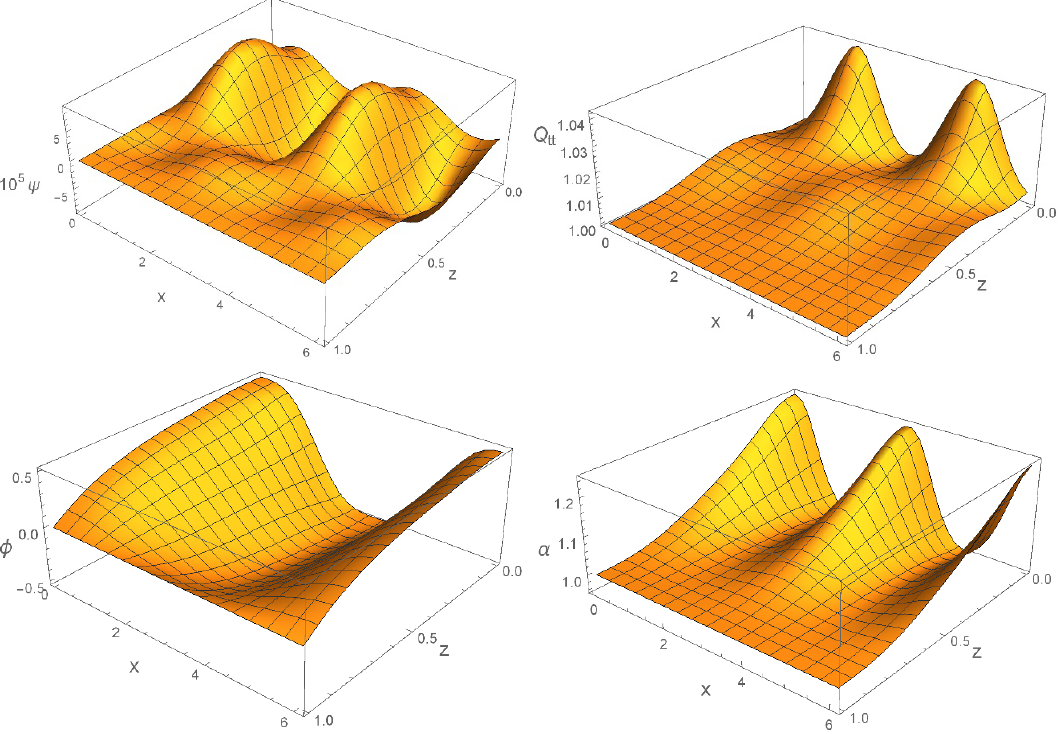
Figure 15 . Bulk solutions for T = 0 : 00737 (cid:22) and k = 1 in the presence of axions. The horizon is at z = 0 and the conformal boundary at z = 1. We have chosen the momentum relaxation strength (cid:28)=(cid:22) = 0 : 5 and the other parameters are the same as